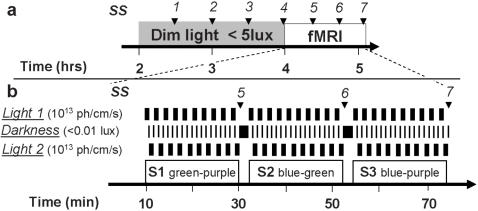
Experimental design.
a. General timeline. Time relative to scheduled wake time (hrs). Arrows: subjective sleepiness assessment (SS 1-7). b. Timeline of the fMRI period and light condition organization. Black bars indicate occurrence of the different conditions. Note that the combination of light 1 and 2 changes from one session to the other. S1-3: sessions 1 to 3 during which 3 combinations of light are employed (combination order is given as example). Time in minutes after entering the scanner. Arrows: subjective sleepiness assessment (SS 5-7).